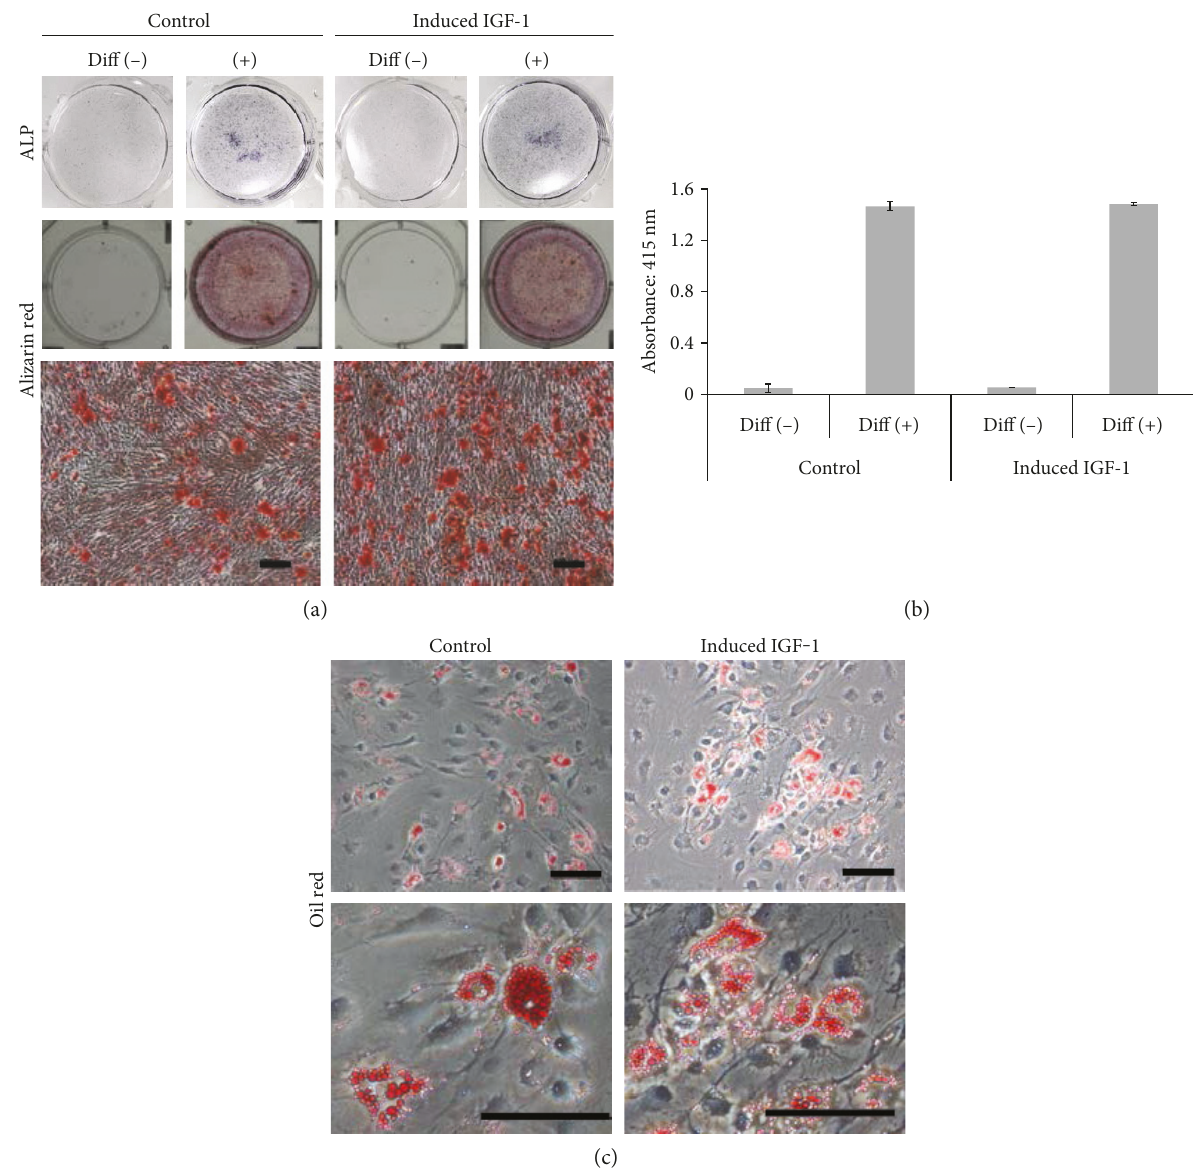
Figure 5: E ff ect of IGF-1 transduction on osteogenic and adipogenic di ff erentiation of human Syn-MSC. (a) Osteogenic di ff erentiation assay using ALP staining after 1 week of di ff erentiation (upper). Alizarin red staining after 3 weeks of di ff erentiation (lower). Scale bars =500 μ m. (b) Quantitated alizarin red staining values after osteogenic di ff erentiation in the control versus induced IGF-1 groups. (c) Adipogenic di ff erentiation after 3 weeks in a di ff erentiation medium using oil red staining. Scale bars =100 μ